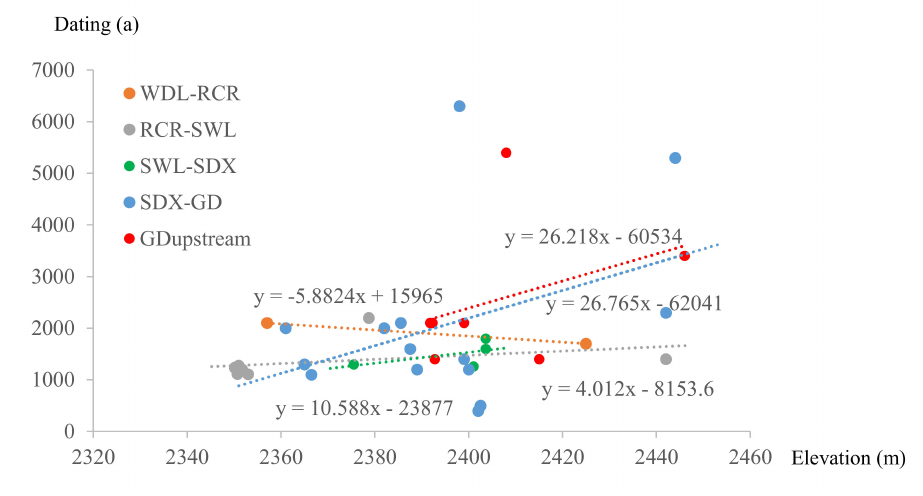
Figure 9. Unprocessed OSL dating data.